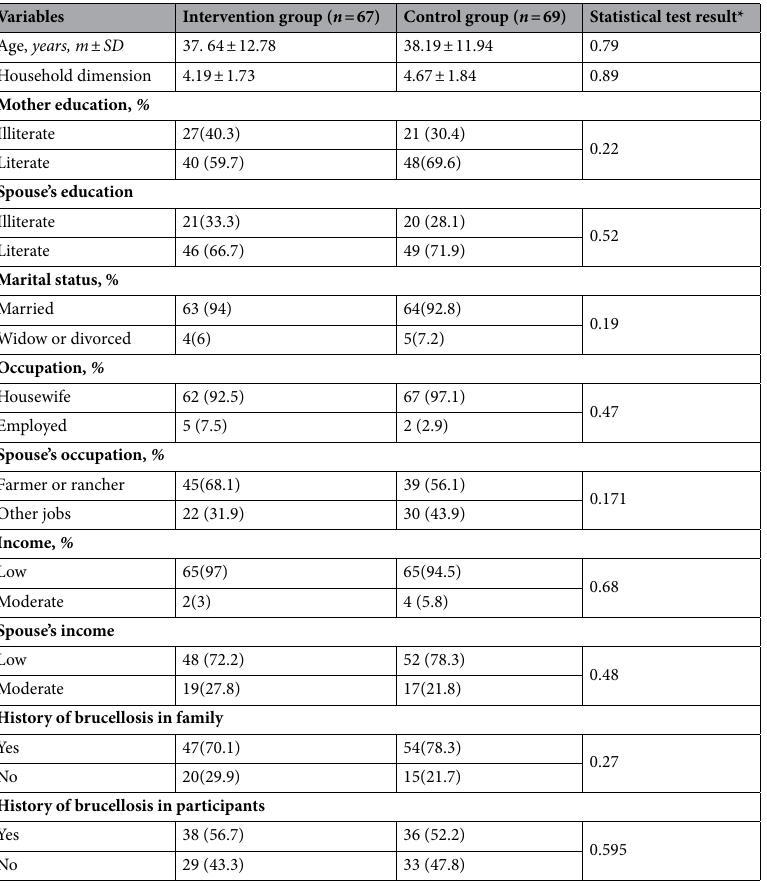
Table 3. Participant’s socio-demographic characteristics. N number of eligible participants; ± standard division; *Testing significant change between control and experimental groups which is significant at the 0.05 level.